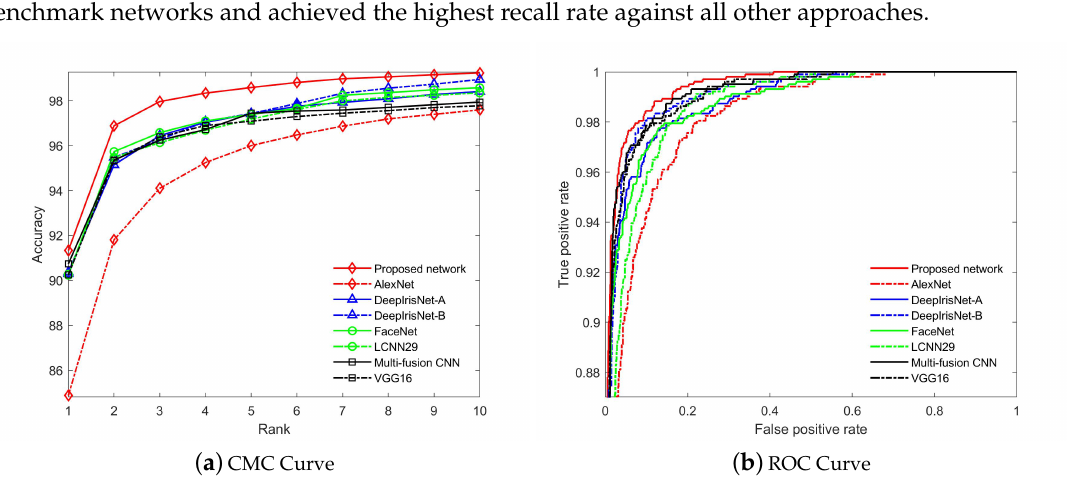
Figure 7. Performances of recognition and verification tasks on UBIPr distance database. The figures are the best to view in